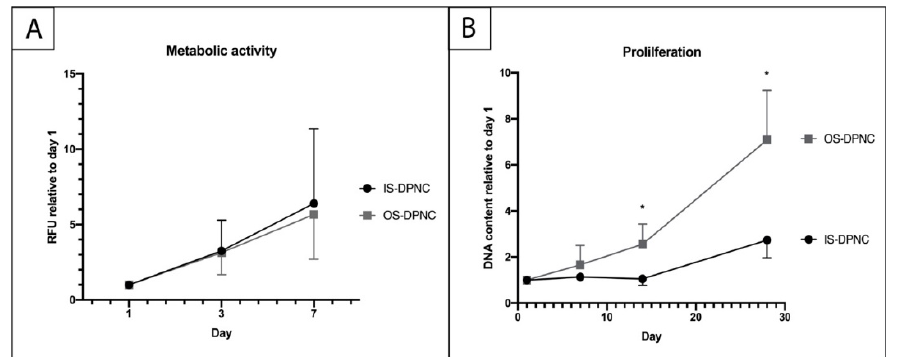
Figure 3. Evaluation of ASC metabolic activity and proliferation on DPNC zones. DPNC zones were seeded with 5 × 10 3 cells and cultured for 24 h until the first time of measurement of the metabolic activity in an alamarBlue assay ( A ) and proliferation in PicoGreen assay ( B ). The relative increase in MMA of ASCs was significant over time ( p = 0.004) and similar on both DPNC zones (n = 5). The DNA content of ASCs increased significantly on OS-DPNC in comparison to IS-DPNC after 14 and 28 days of culture, indicating that ASCs proliferate more on OS-DPNC (n = 3; * p < 0.05; mean ± SD).